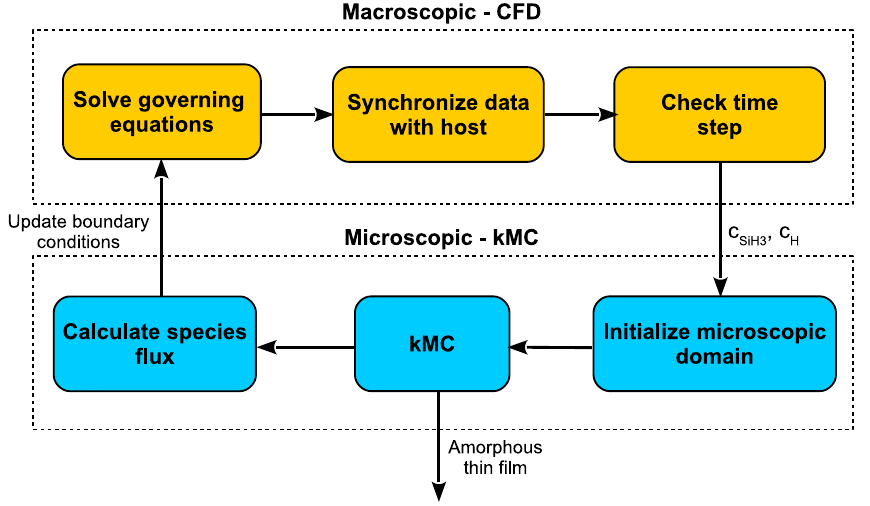
Figure 11. Multiscale simulation workflow detailing the coordination between the macroscopic and microscopic